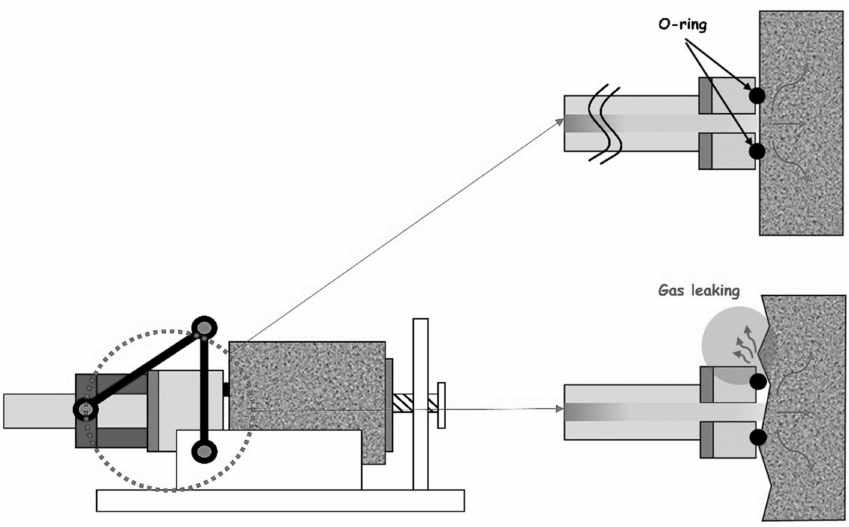
Figure 5. Permeability measurement using the portable probe